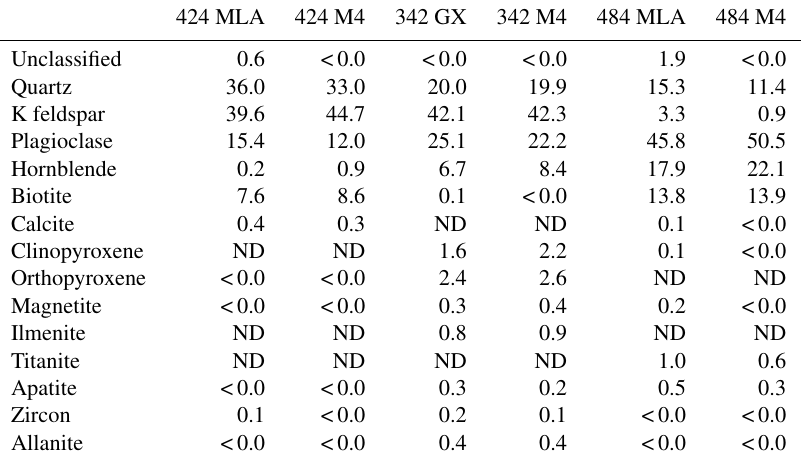
Table 3. Modal mineralogy from the M4 classification in area-% (MLA indicates thin section analyzed by MLA in XBSE mode, GX indicates MLA in GXMAP mode, M4 indicates thin section analyzed by the M4 Tornado. <0.0 means that the mineral was detected in a quantity less than one